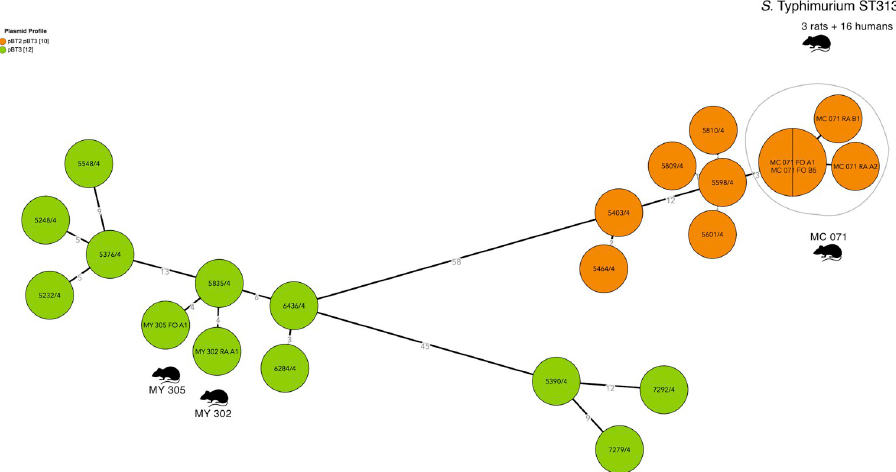
Fig 4. Plasmid profiles of S . Typhimurium ST313 human and rat isolates according to the plasmid profiles of ST313 Lineage 2 isolates described by Pulford et al . [7]. Minimum spanning tree (MSTree V2) comparing all S . Typhimurium ST313 in this study. 58 alleles separate the two mixed clusters (human and rats isolates) with different plasmid content: in orange, isolates harboring plasmids pBT2 and pBT3; in green, isolates harboring pBT3, only. Rat drawing by Francisca Are´valo from